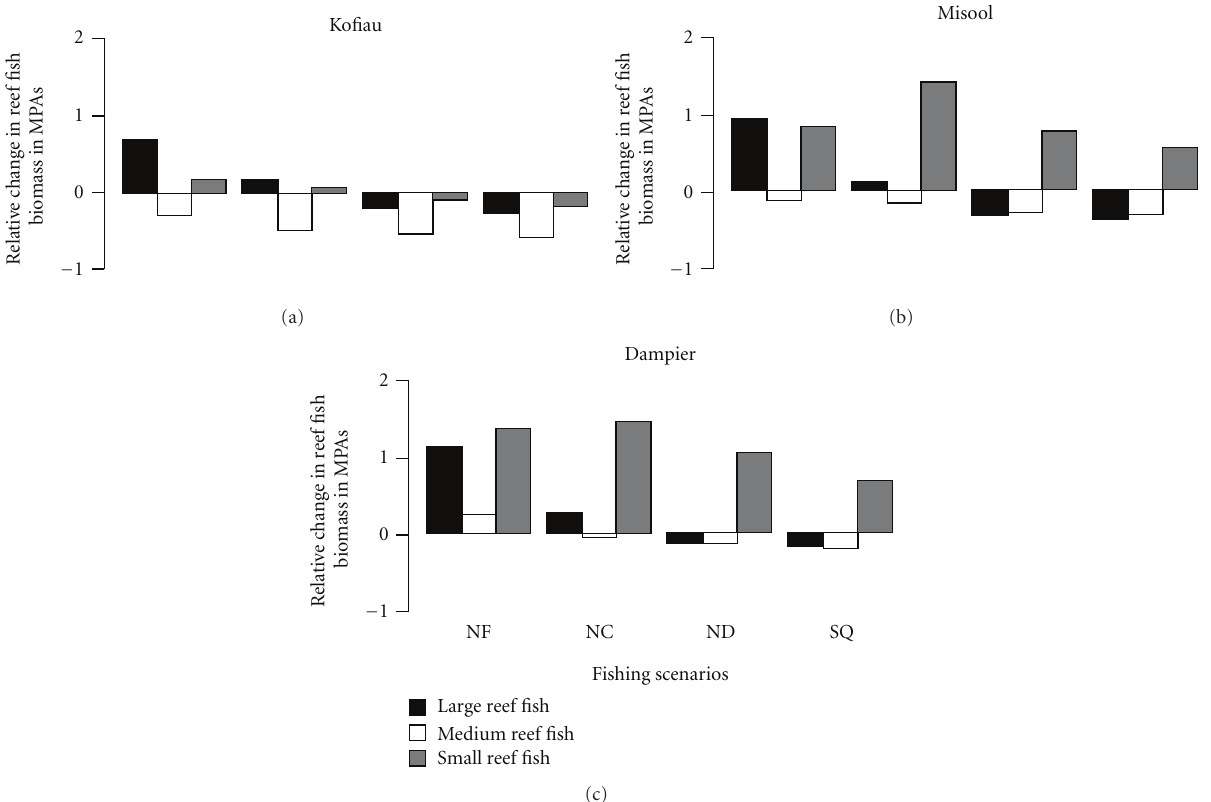
Figure 3: Relative biomass density changes inside the three analysed MPAs after 20-year simulation using Ecospace model. The graphs show the change in biomass relative to the base (2005) biomass of large, medium, and small reef fish. The fishing restriction scenarios are shown on the horizontal axis: NF: no fishing, NC: no commercial, ND: no destructive, and SQ: status quo. Black bars represent large reef fish, white bars represent medium reef fish, and grey bars represent small reef